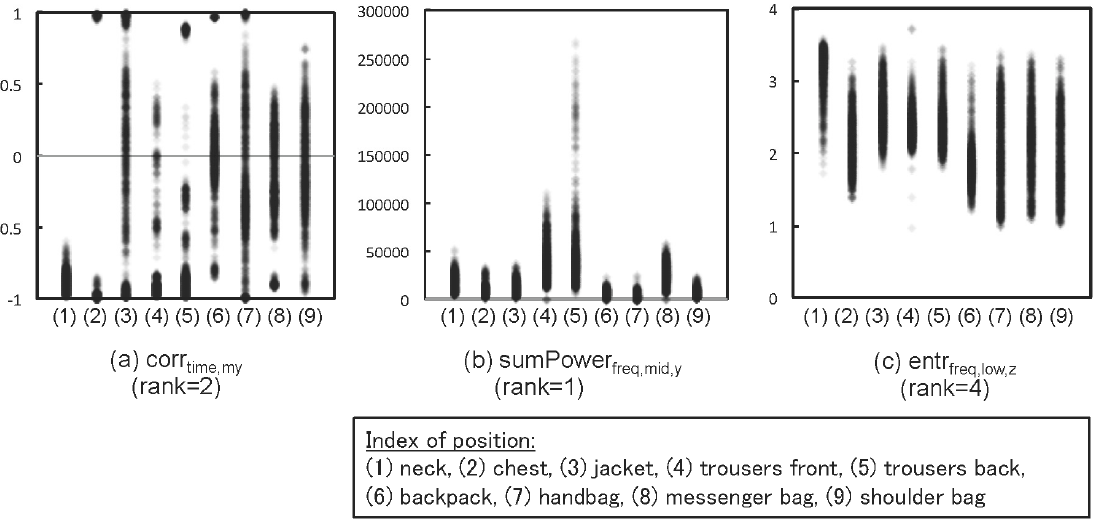
Figure 7. Scatter plot of the distribution of features by target positions. The thick and dark portion indicates dense